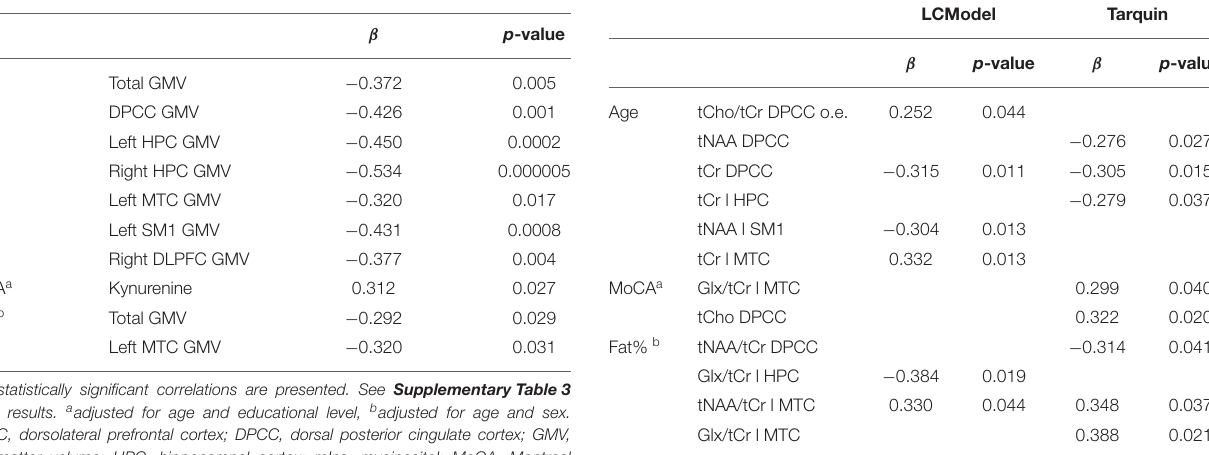
TABLE 3 | The effect of age, MoCA, and fat% on brain GMV and peripheral inflammation.